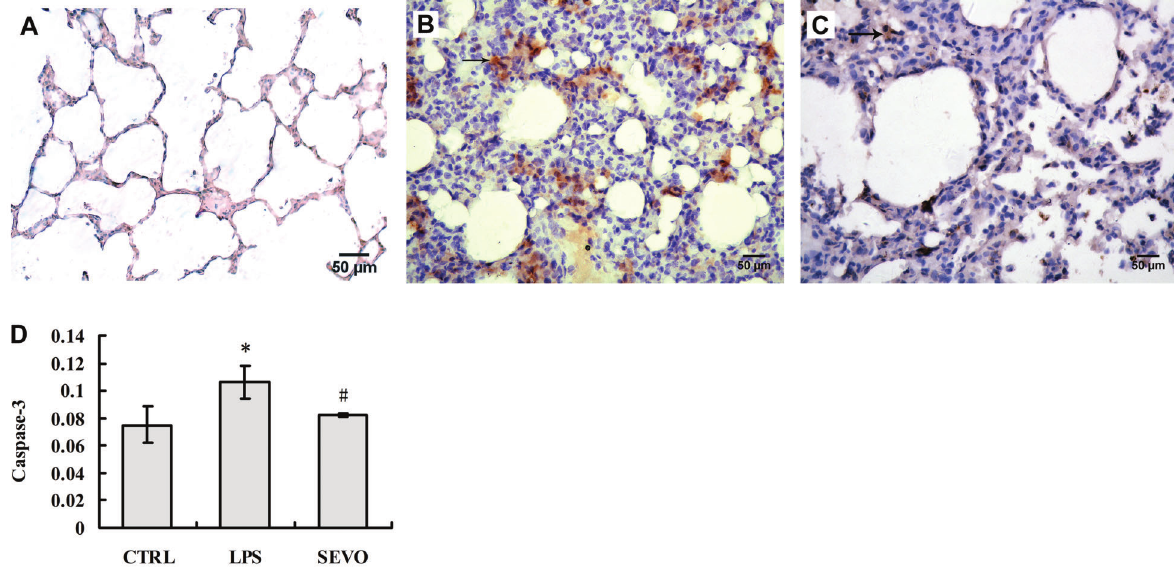
Figure 5. Caspase-3 levels in lung tissue samples. Immunohistochemical staining for caspase-3 (magni fi cation, 400 (cid:1) ) in the CTRL ( A ), LPS ( B ) and SEVO groups ( C ). D , Caspase-3 staining quantitation based on integrated optical densities in the lung tissues. Data are reported as means ± SD (n=6 per group). CTRL: control group injected intratracheally with normal saline; LPS: injected intratracheally with lipopolysaccharide; SEVO: injected with LPS plus inhaled sevo fl urane for 30 min. *P o 0.01 vs CTRL; # P o 0.01 vs LPS (ANOVA).